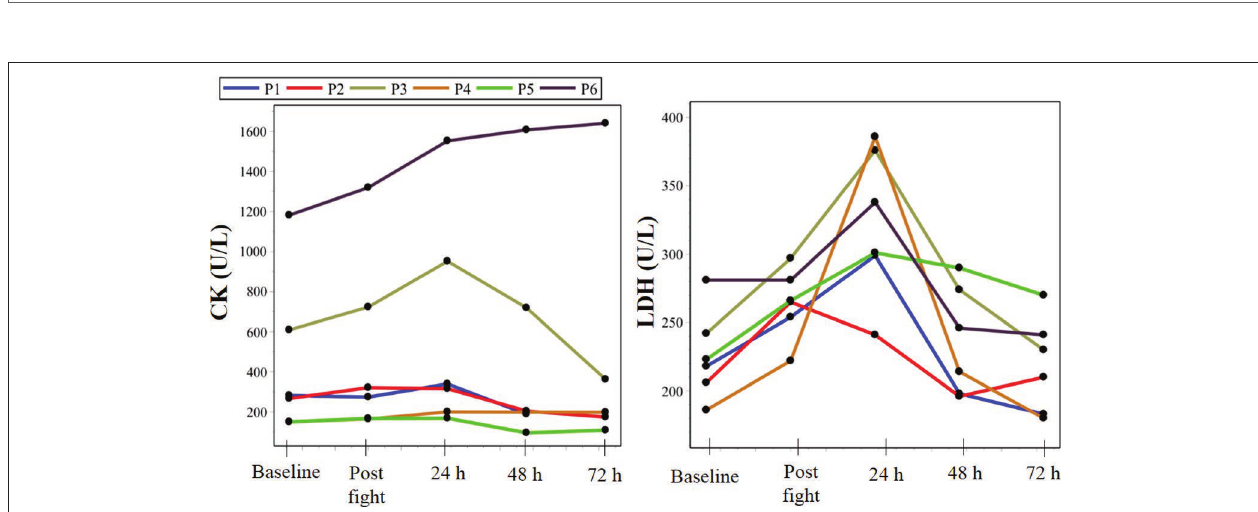
FIGURE 3 | Biochemical markers, represented by creatine kinase (CK) and lactate dehydrogenase (LDH). CK, creatina quinase; LDH, lactate dehydrogenase; P, parathlete. Parathletes I and II were world champions in their respective